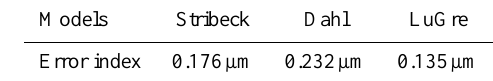
Table 3. Error index for friction models. Models